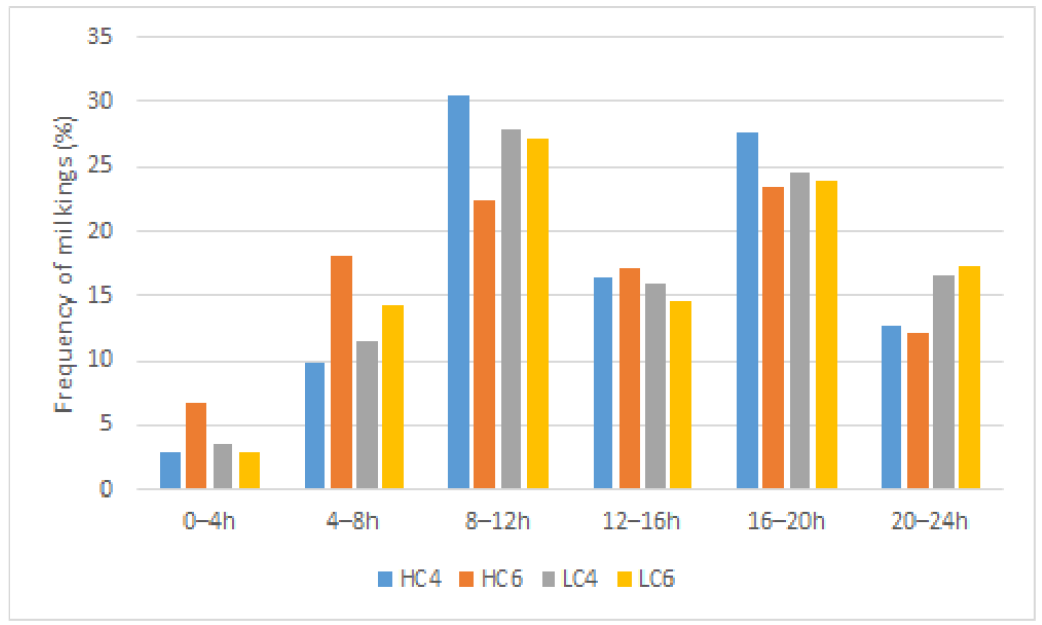
Figure 6. Time schedule of milkings (SM) of the different groups. Abbreviations. HC4, High concentrate allocation, MMI set at 4 h. HC6, High concentrate allocation, MMI set at 6 h. LC4, Low concentrate allocation, MMI set at 4 h. LC6, Low concentrate allocation, MMI set at 6 h.